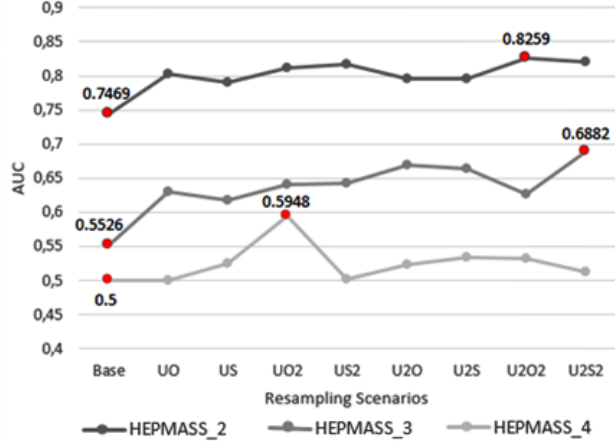
Fig. 3. AUC results of synthetic HEPMASS datasets on resampling scenarios.